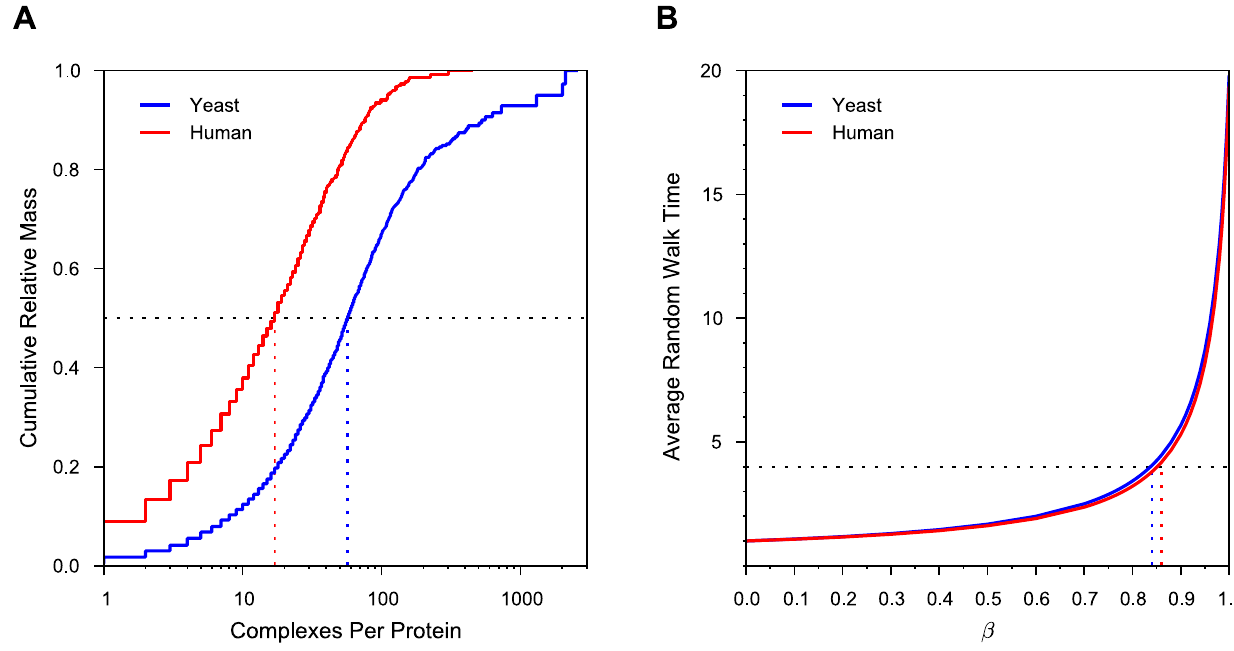
Figure 2. Estimating parameters for information flow weights from the initial datasets. A The parameter m is defined as the weighted median number of complexes per protein: the proteins participating in more than m complexes account for 50% of the total ‘mass’ of all complexes. Here each protein member is assumed to contribute a single unit of mass to a complex. B The parameter b and the average time a randomly placed random walker spends in the protein-protein network are monotonically related. We set b so that the average random walk time is exactly 4 steps.